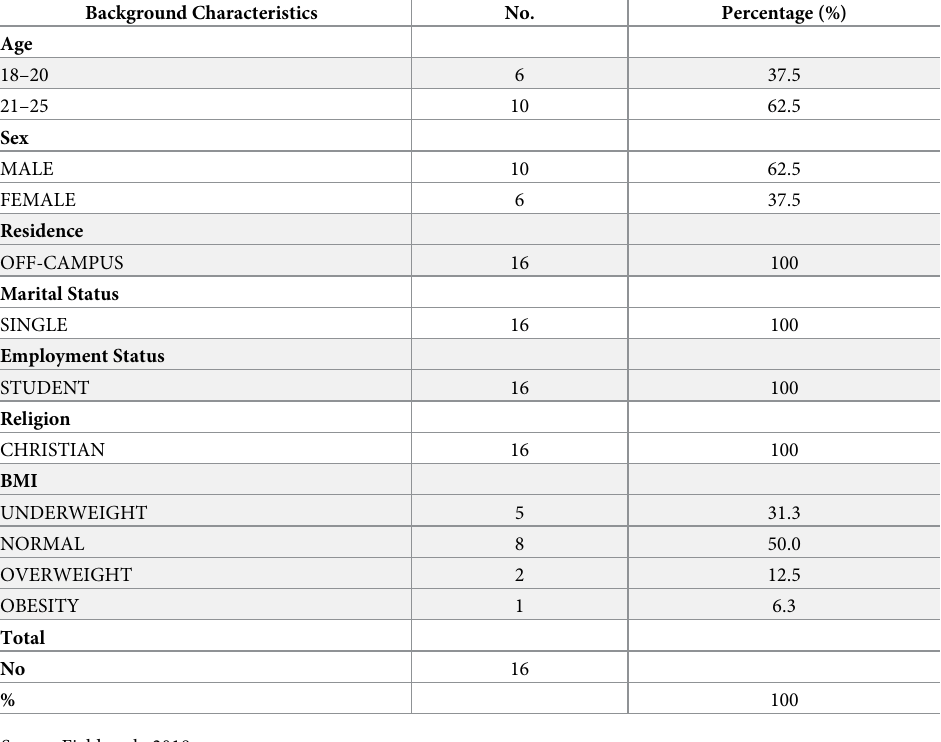
Table 1. Socio-demographic characteristics of